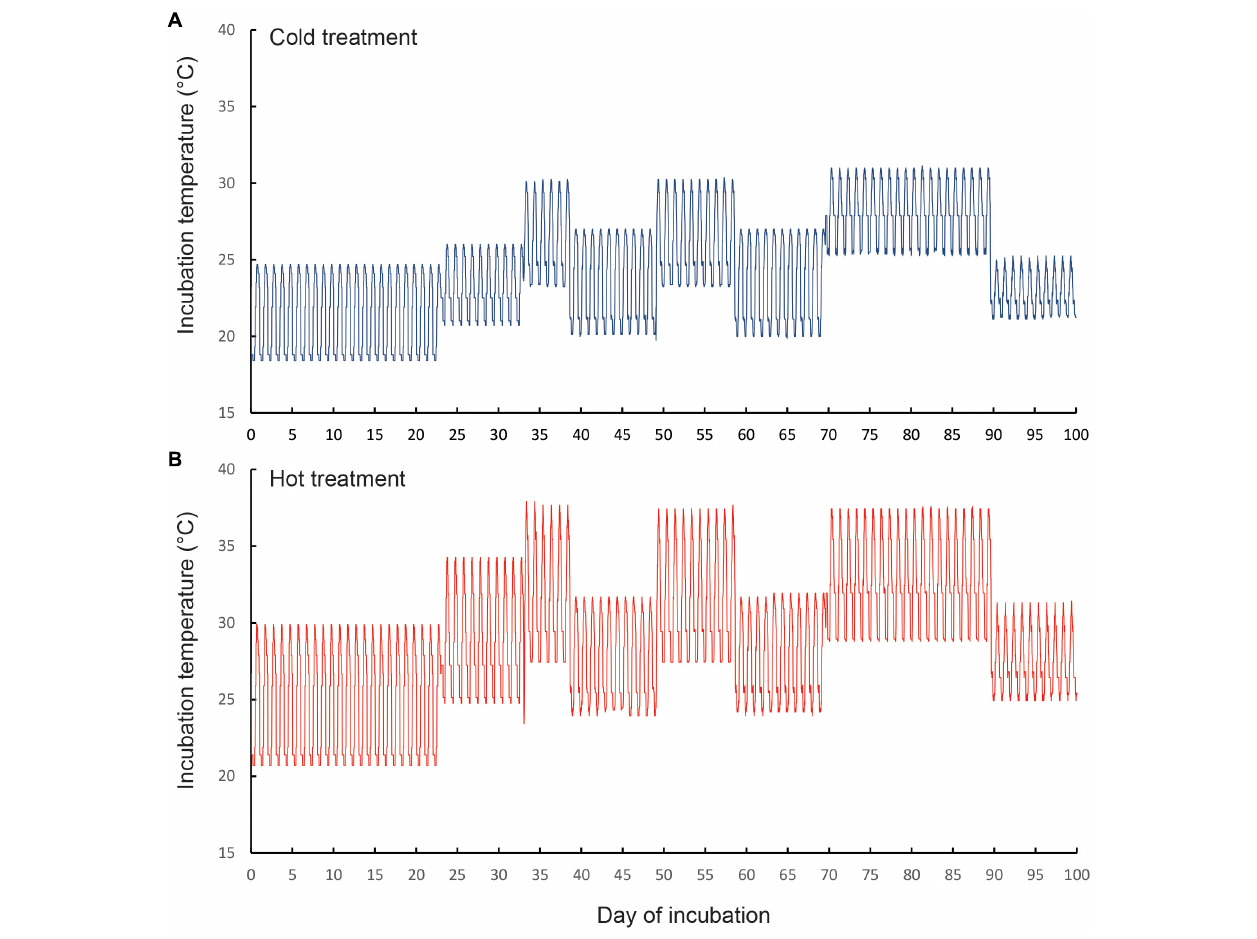
FIGURE 1 | Thermal regimes that we programmed for the (A) cold incubation treatment and (B) hot incubation treatment. The temperature regimes of the cold treatment mimicked thermal regimes that we have recorded inside the communal nests of our focal species Amalosia lesueurii under the current climate (Cuartas-Villa and Webb, 2021). Temperature regimes of the hot treatment are potential nest temperatures likely to occur under future climates. Note that in both treatments, temperatures fluctuated daily, and increased during the incubation period, to simulate the thermal regimes that occur in natural nests over spring and summer. The three elevated spikes in temperature (at around days 35, 55, and 80 of incubation) correspond to heatwaves of varying durations.